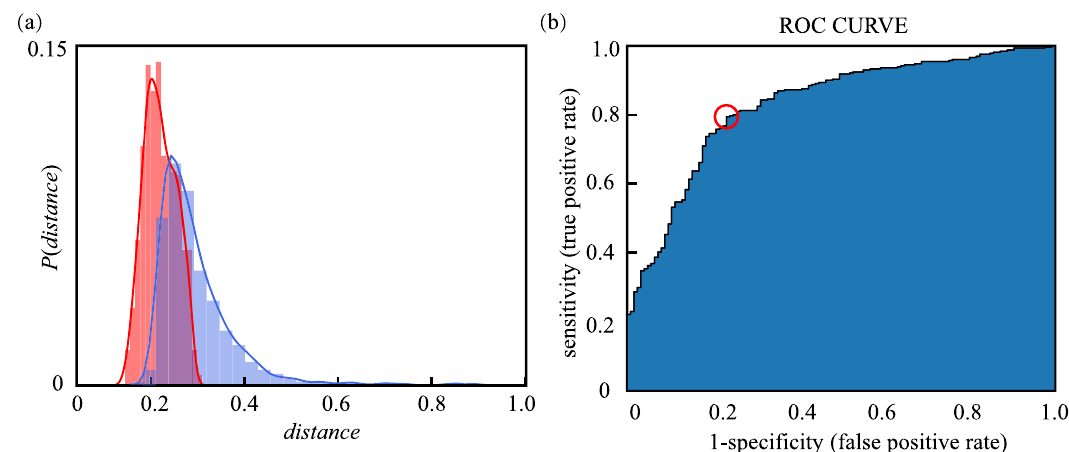
Fig. 2 Optimal decision threshold. a The distribution of the (cid:1) s ð NISSBs ; ISSBs Þ (blue bars) and (cid:1) s ð PISSBs ; ISSBs Þ (red bars); b The ROC-AUC curve for the training set.